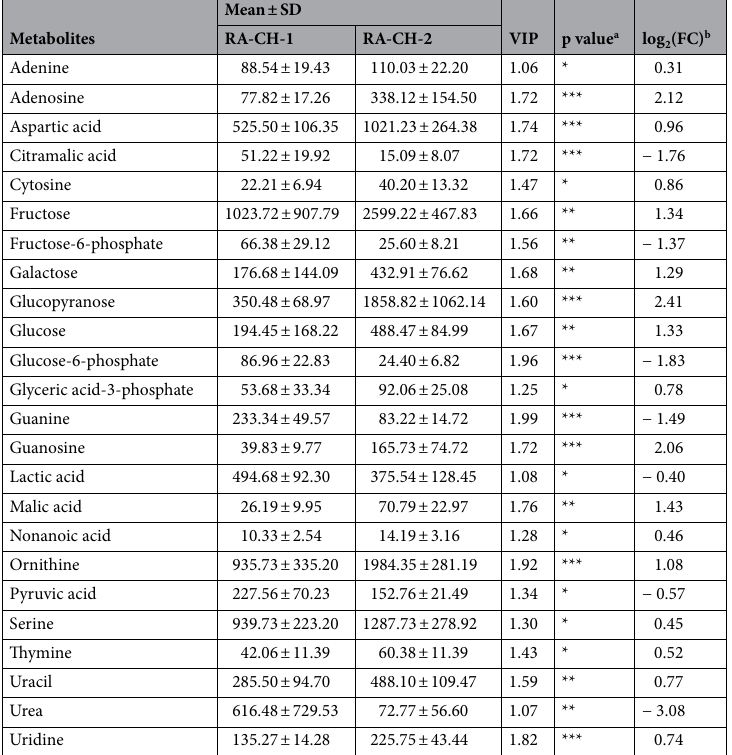
Table 3. Differential intracellular metabolites between RA-CH-1 and RA-CH-2 groups. a *p < 0.05; **p < 0.01; ***p < 0.001. b FC: fold change in